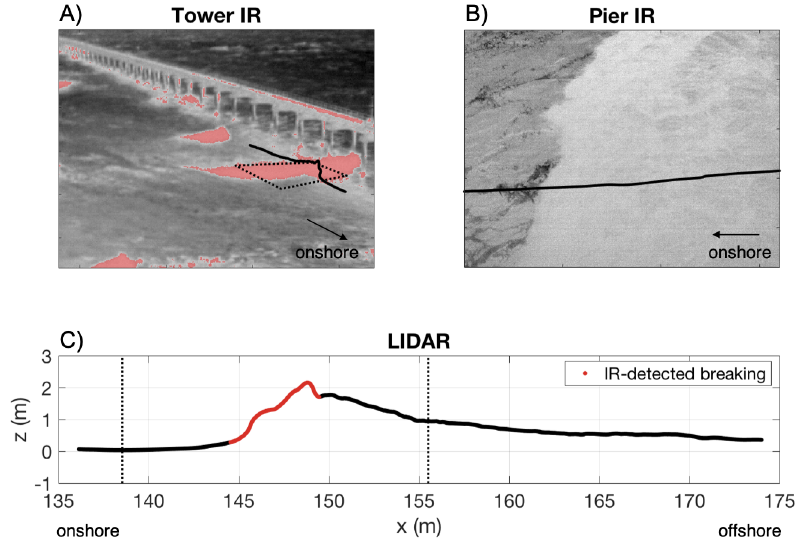
Figure 1. ( A ) An IR image of the surf zone and the pier are shown with detected breaking indicated by the transparent red layer. The corresponding LIDAR transect (solid black curve) and the pier IR camera field of view (dashed outline) are projected into the image; ( B ) corresponding example image from the pier IR camera with the LIDAR transect (black line) projected into the image; ( C ) corresponding example LIDAR transect (same as shown in ( A , B )), with active breaking highlighted in red on the front face of the wave, and the field of view of the pier IR camera marked by dashed lines.